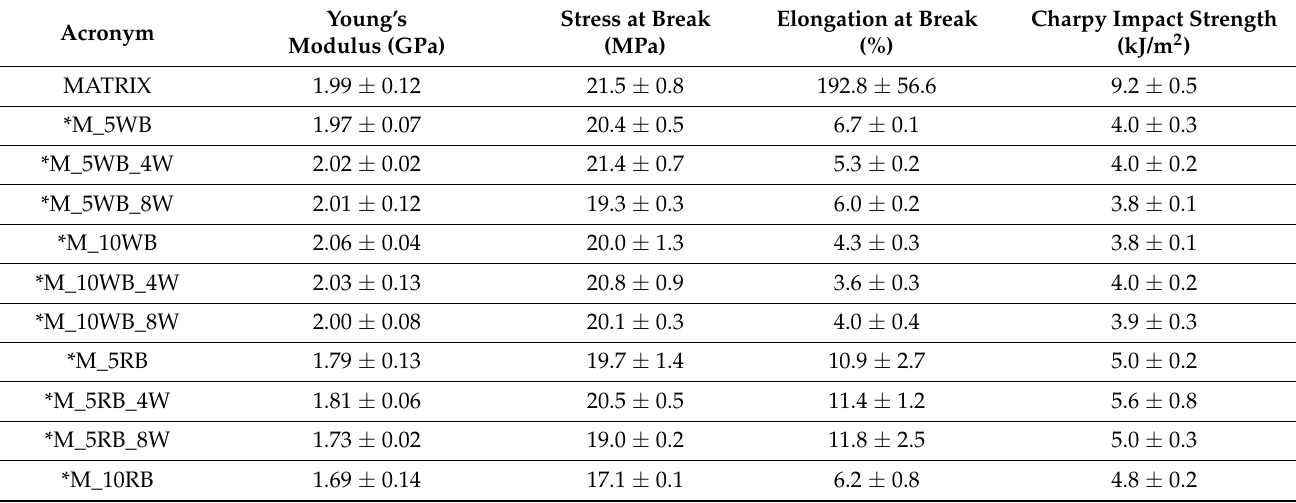
Table 2. Quasi-static mechanical properties and impact behavior of studied